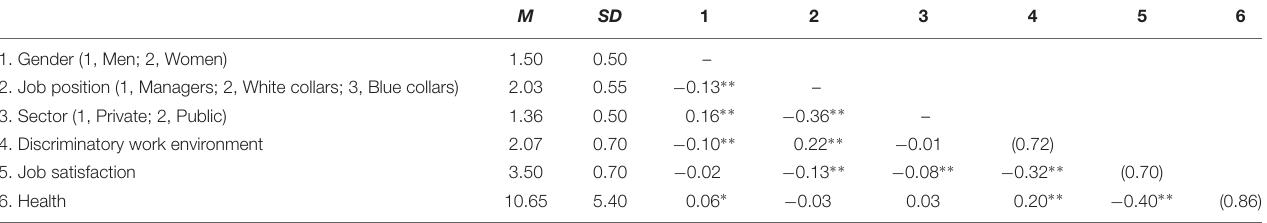
TABLE 1 | Internal consistencies, means, standard deviations, and correlations among variables.